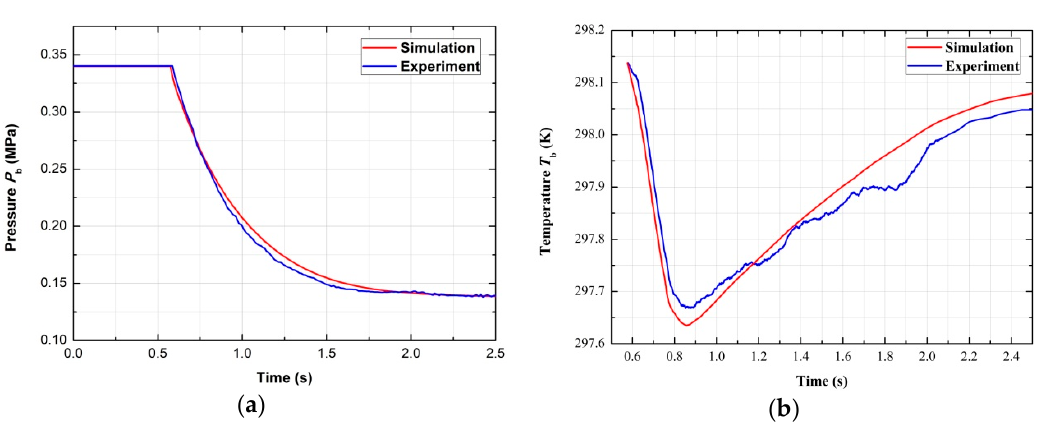
Figure 22. Curves of pressure and temperature when chamber a is charging: ( a ) Pressure curves; ( b ) Temperature curves.